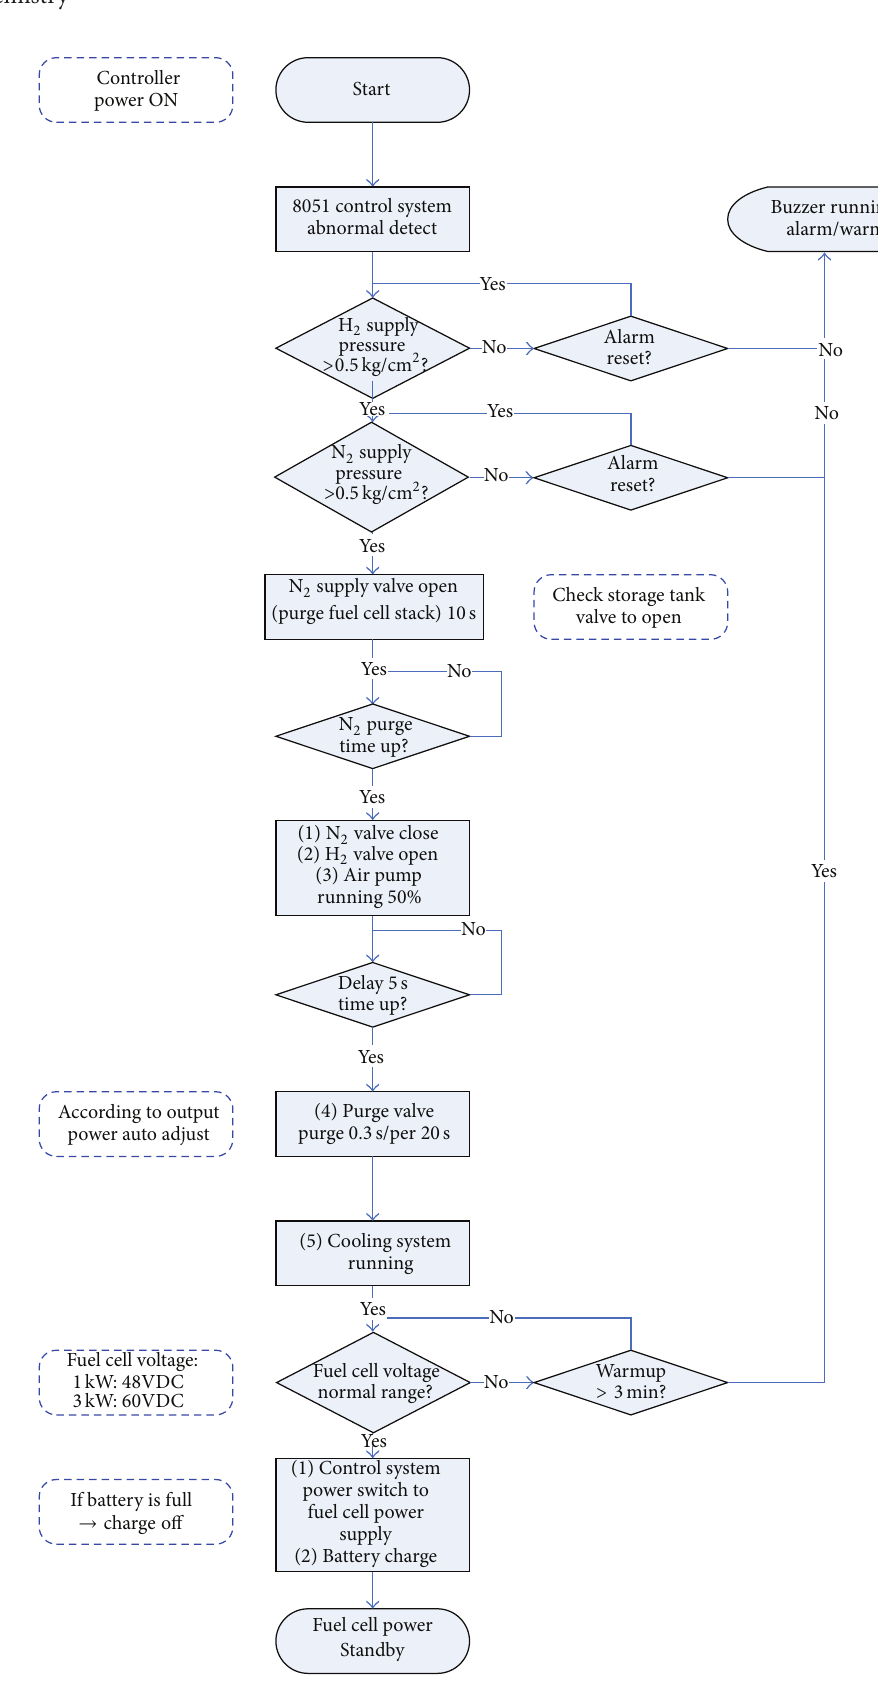
Figure 5: Operational flow of 8051 control system during warmup